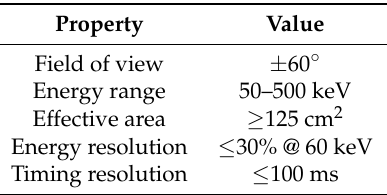
Figure 1. An overview of the SPHiNX payload, including the plastic and GAGG scintillators, the shielding, electronics, and the power-supply module. Table 1. SPHiNX